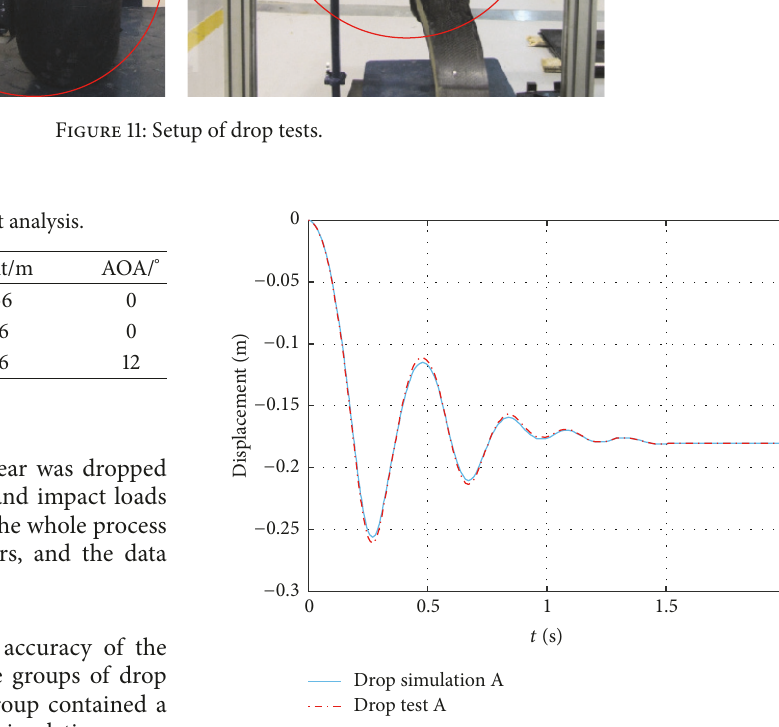
Figure 12: Comparison of results for drop analysis